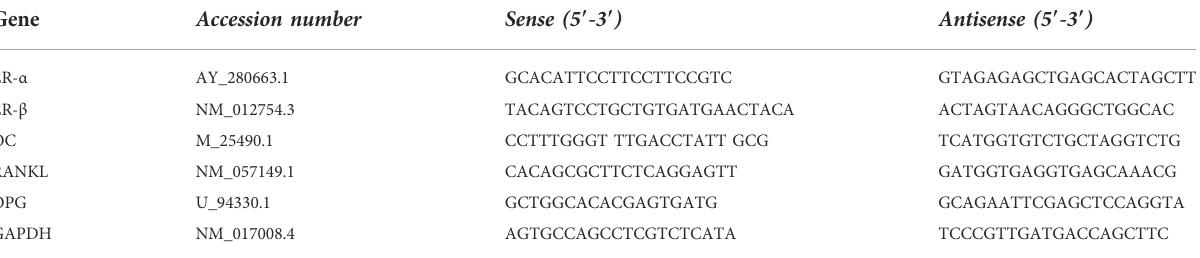
TABLE 1 PCR primers sequences of the studied